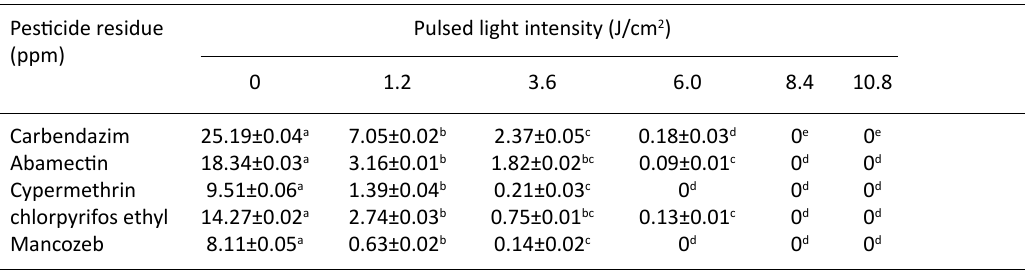
chlorpyrifos ethyl